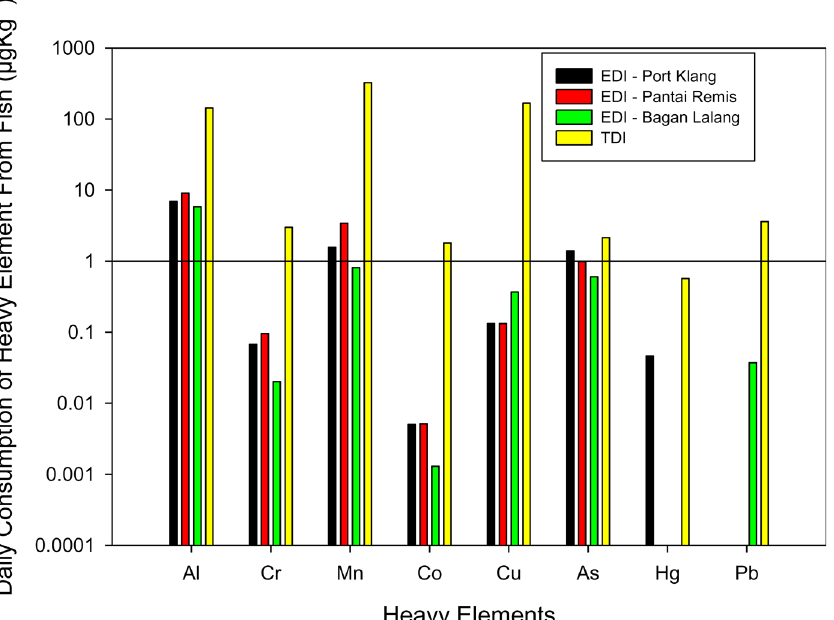
Fig 4. Heavy metal concentrations in fish of Port Klang, Pantai Remis and Bagan Lalang: Comparison of Daily Estimated Intake (EDI) with the Tolarable Daily Intake (TDI) of heavy